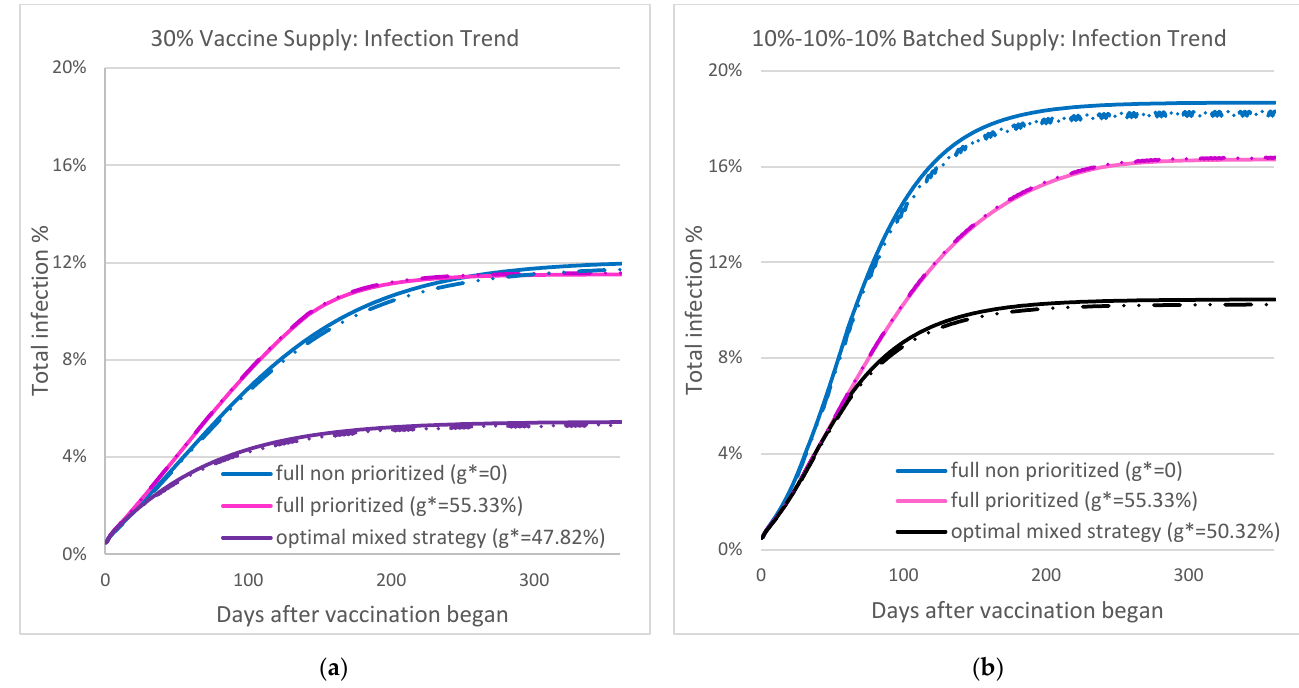
Figure 5. The two figures show overall infection under three vaccination strategies—optimal mixed strategy, full prioritized, and full non-prioritized—when the vaccine supply level is 30%, R 0 = 1.2, and initial infection is 0.5%. The solid curves are results from the ODE-based system and the dotted-dashed curves are results from RealOpt agent-based simulation. ( a ) Results from non-interrupting supply. ( b ) Results from batched supply. Note the optimal mixed strategy from the batched supply (b. black curves) results in 92% increase in attack rate over the non-interrupted supply (a. purple curves).